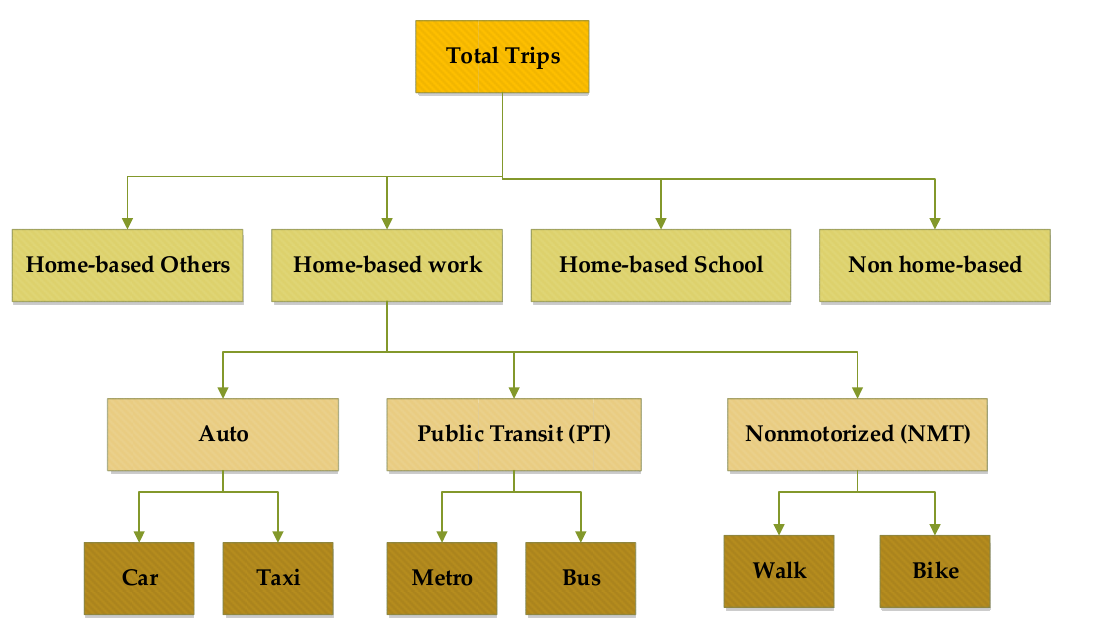
Figure 5. Nested logit model.